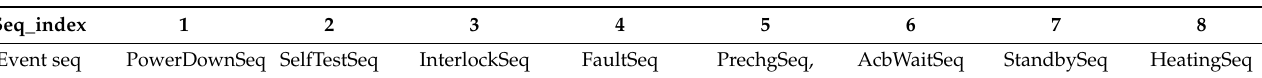
Figure 6. Pattern of available parameters and selected parameters (blue). Table 4. Index of event